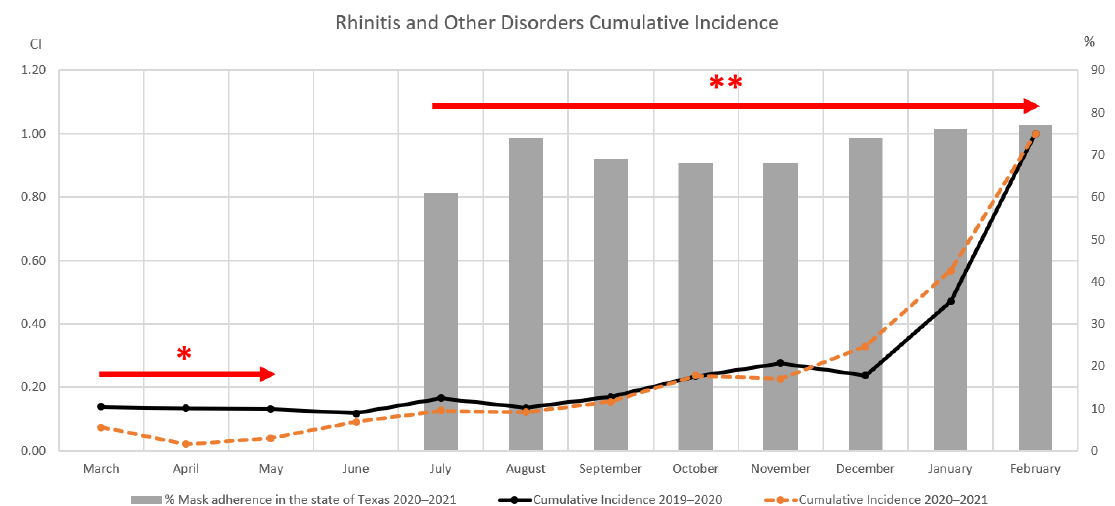
Figure 4. Cumulative rhinitis and other disorder incidence with Texas mask